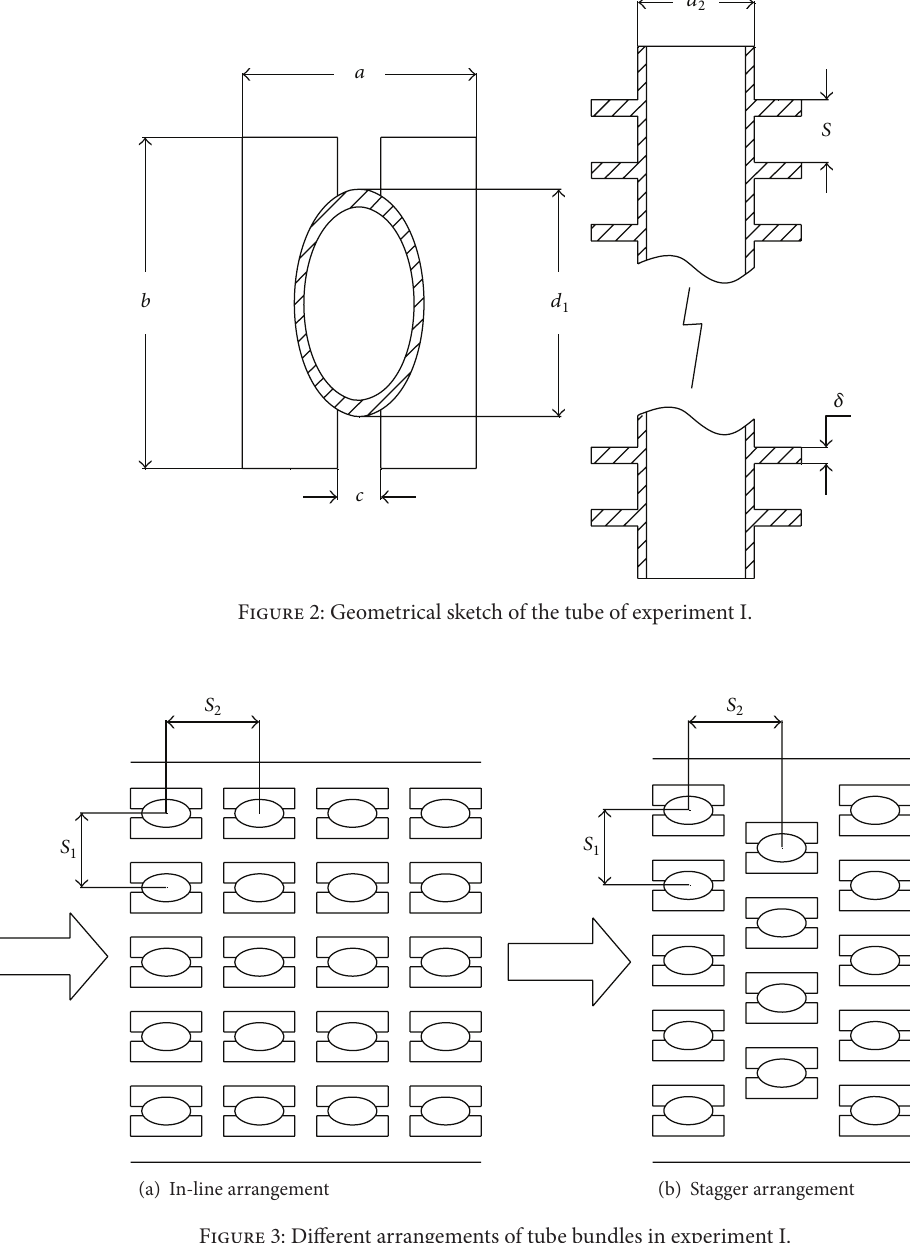
Figure 3: Different arrangements of tube bundles in experiment